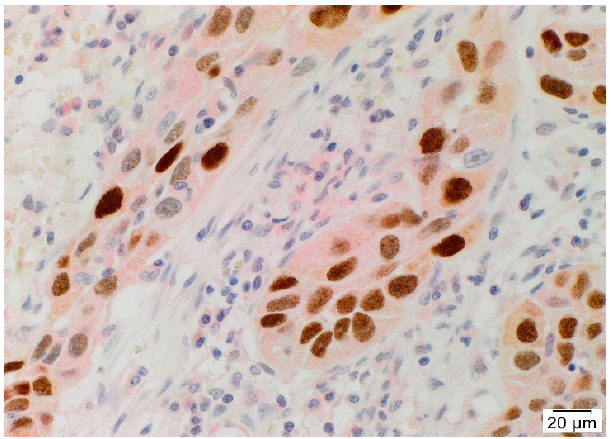
Figure 2. Representative double immunohistochemical-stained section of metastatic head and neck cutaneous squamous cell carcinoma demonstrating cytoplasmic expression of angiotensinogen (red) in CSCs with nuclear expression of SOX2 (brown), within the TNs. Cell nuclei were counter-stained with hematoxylin (blue). Original magnification: 400×. n = 2.